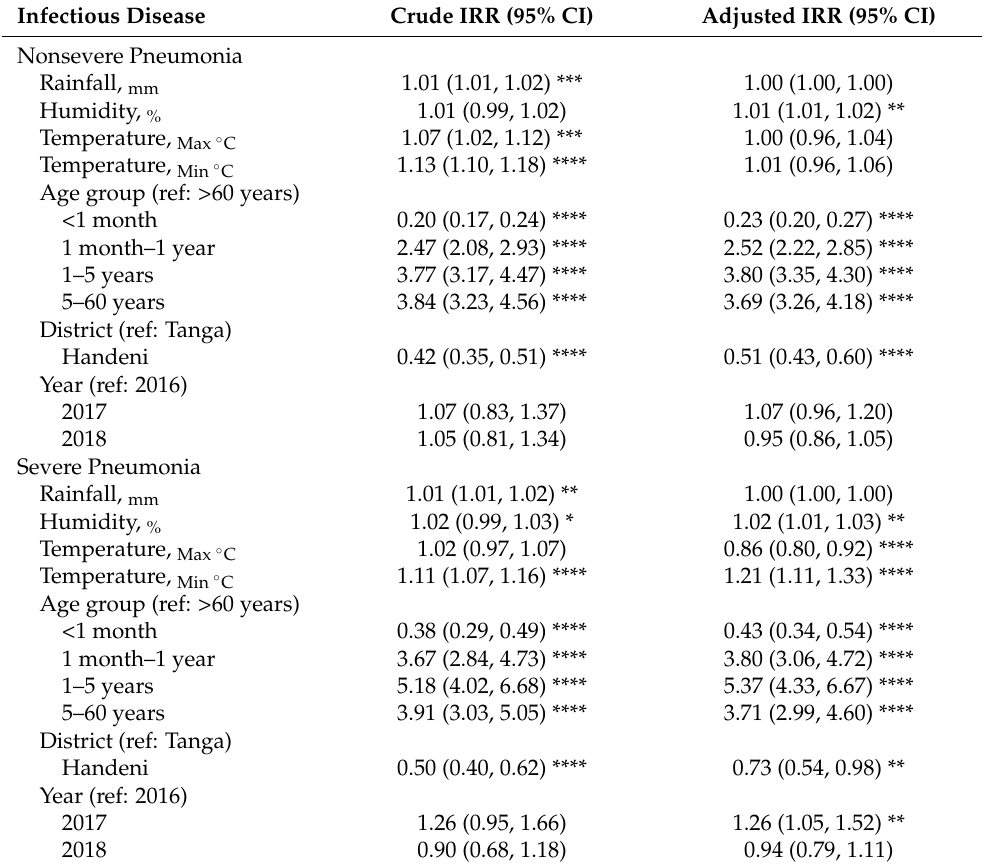
Table 2. Annual mean differences of pneumonia infections and climate variables between the Tanga and Handeni districts by